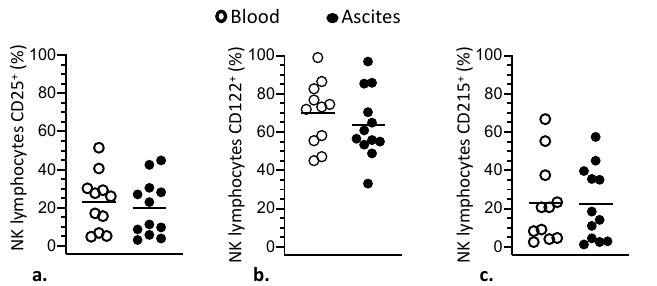
Figure 3. Comparison of blood (white circle) and ascites (black circle) of women with advanced EOC in relation to the expression of CD25 ( a ), CD122 ( b ) and CD215 ( c ) molecules on NK lymphocytes, which comprise IL-2 and IL-15 receptors. Values are presented as percentage of positive cells and mean.